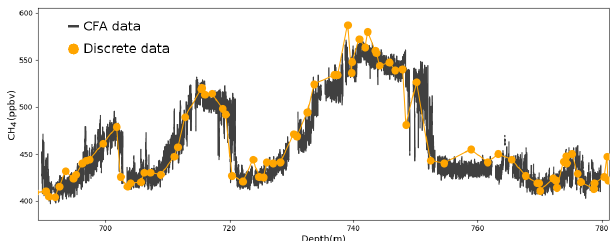
Figure 2. Illustration of a corrected CFA record (in black) by matching an already-calibrated record (orange dots; Loulergue et al.,